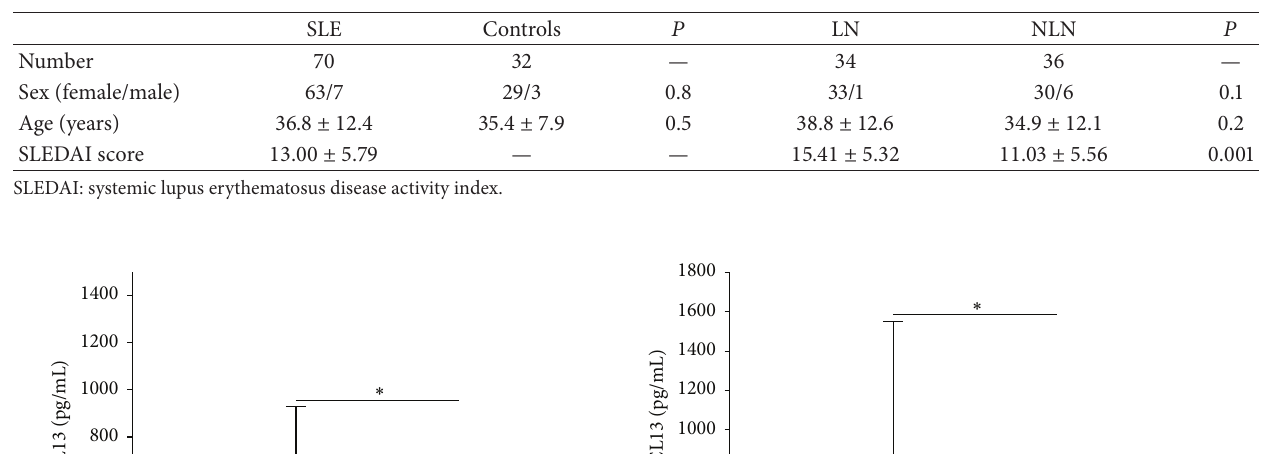
Table 1: Clinical characteristics of patients with SLE and healthy controls.